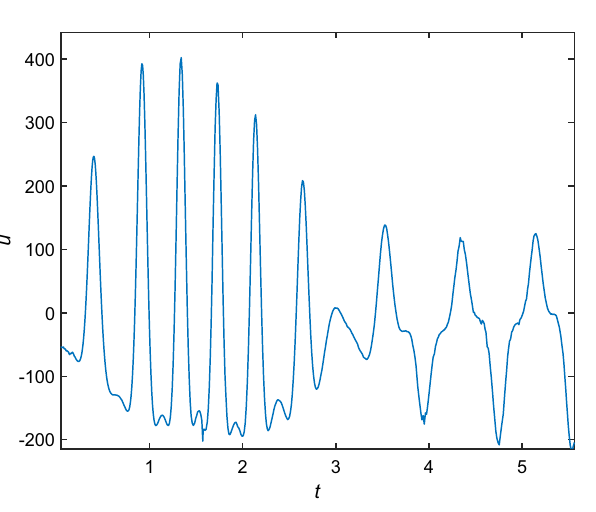
Fig. 13 The phase diagram on the x 1 − y 1 − z 1 ( x 2 − y 2 − z 2 ) space